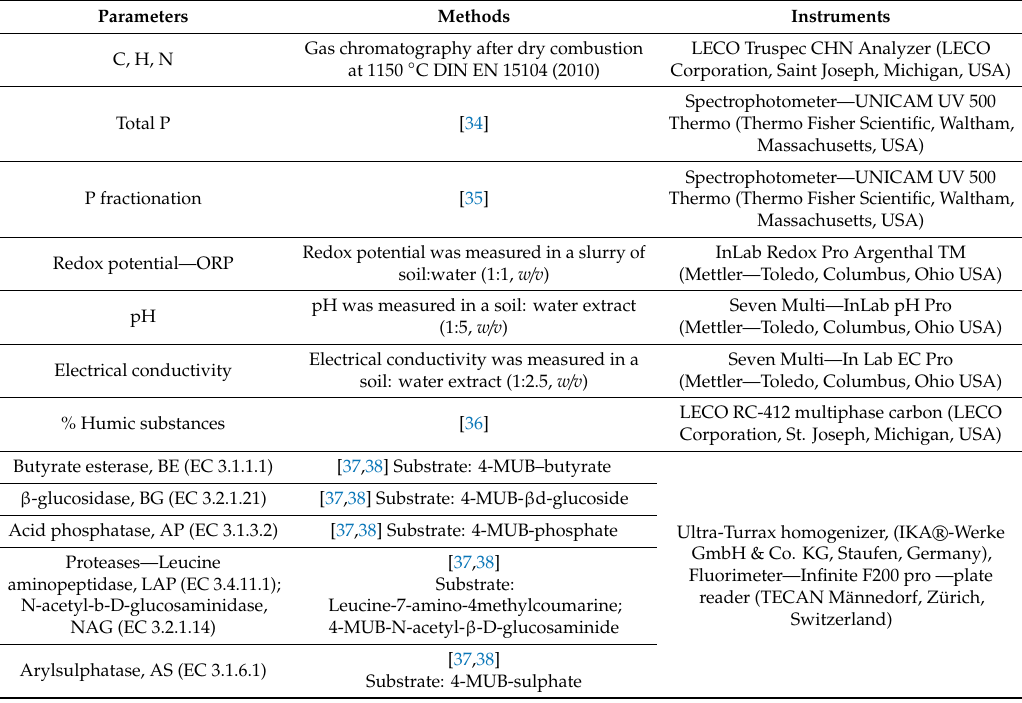
Table 1. Methods and equipment for soil